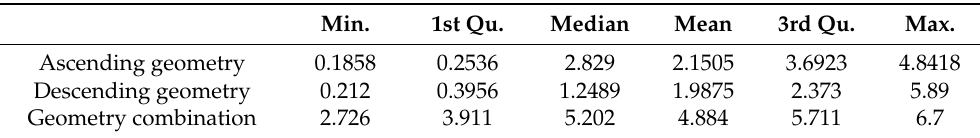
Figure 8. Histogram of the processing time of the sites in ascending ( A ) and descending ( B ) geometries and geometry combination ( C ) in days. Table 1. Statistical descriptors of processing times in ascending and descending geometries and geometry combination (in